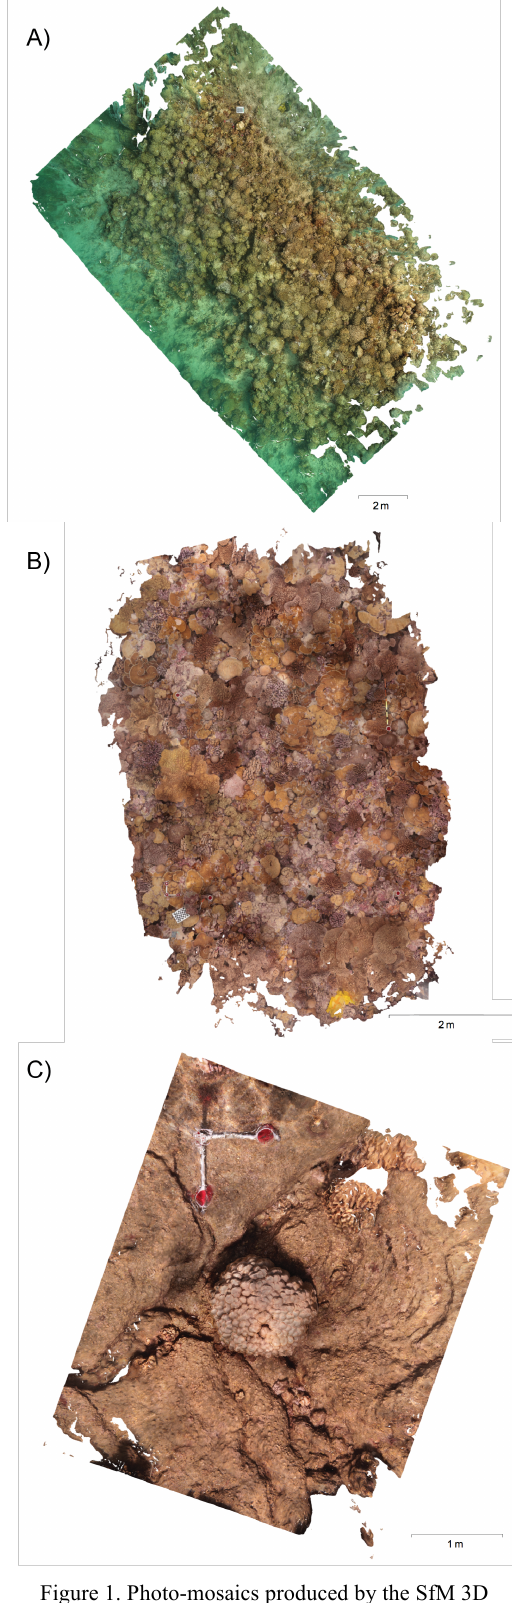
Figure 1. Photo-mosaics produced by the SfM 3D reconstruction process for the three spatial scales used in this study: a) 10x10-m (100m 2 ), b) 4x4-m (16m 2 ), and c) individual coral